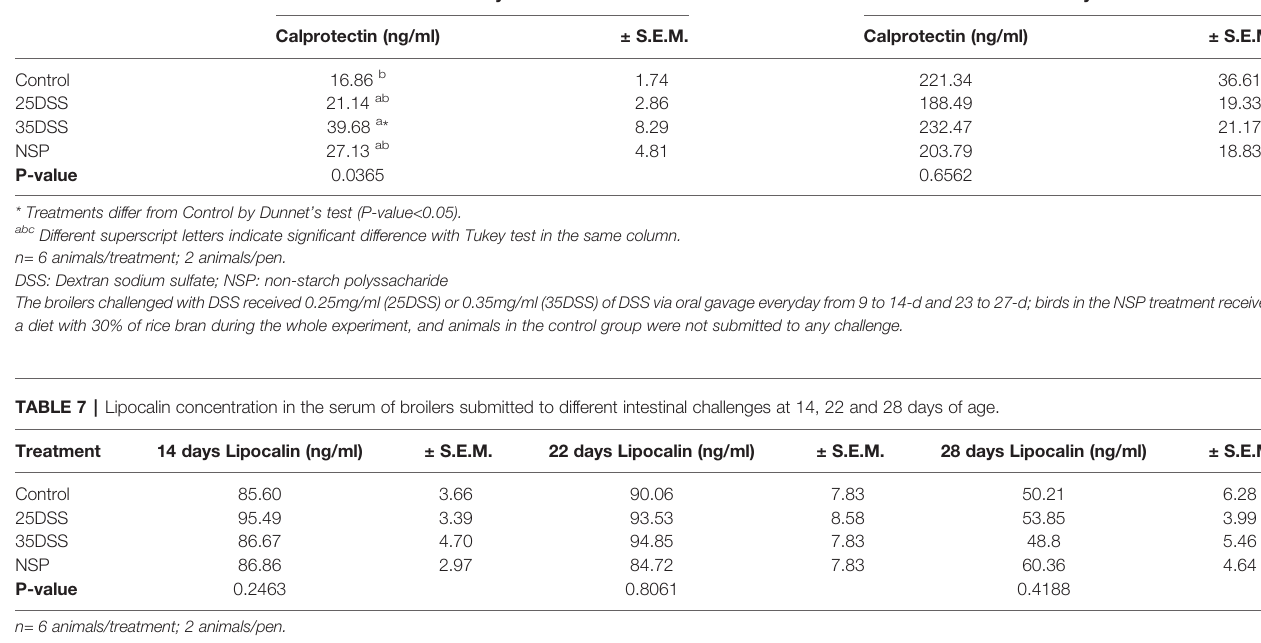
TABLE 6 | Calprotectin concentration in the serum of broilers submitted to different intestinal challenges at 14 and 22 days of age. Treatment